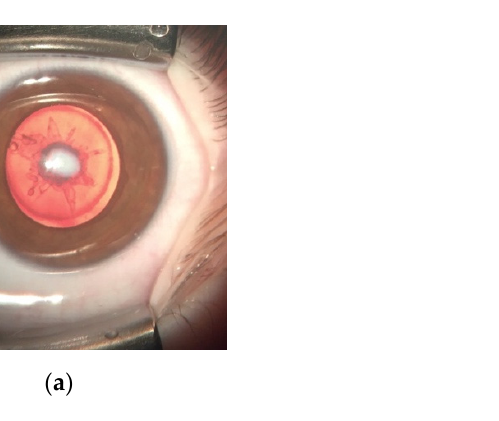
Figure 1. ( a ) Polar anterior congenital cataract; ( b ) Nuclear congenital